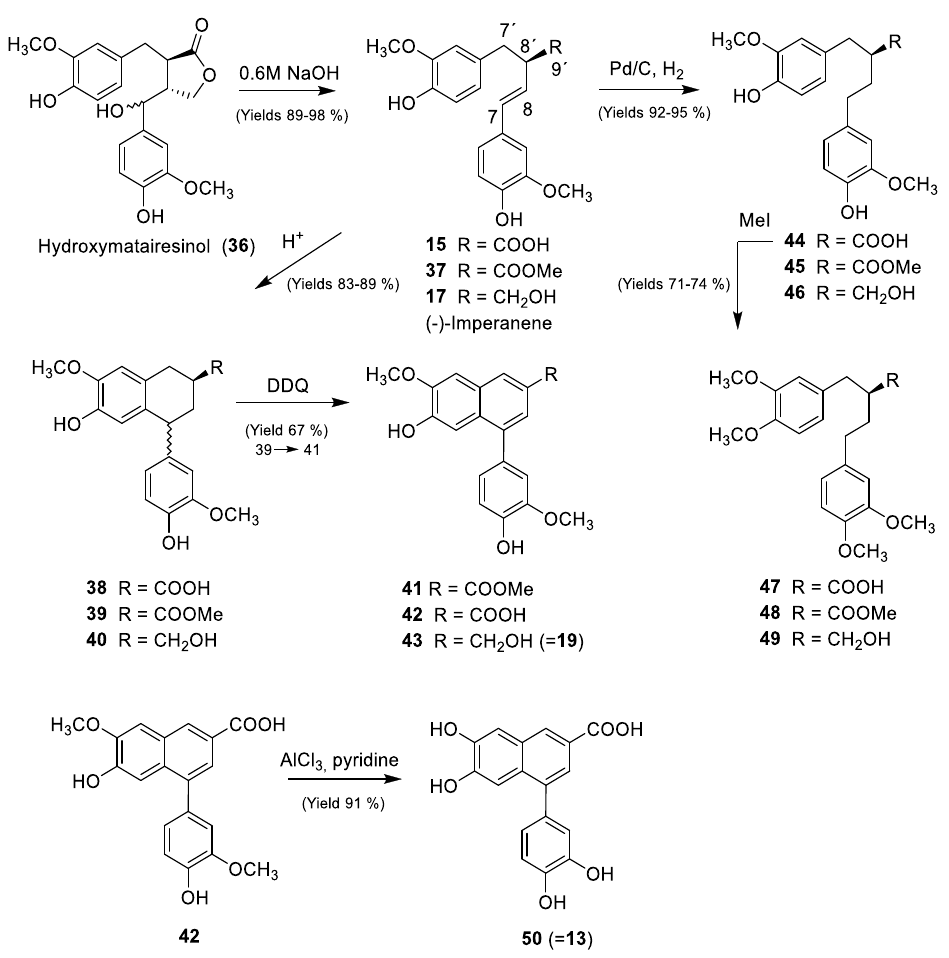
Preparation of various 9-norlignans from hydroxymatairesinol. This generalized shows the fundamental chemical transformations. For more detailed information on the interconversions and transformations including reaction conditions, see the supplementary material.